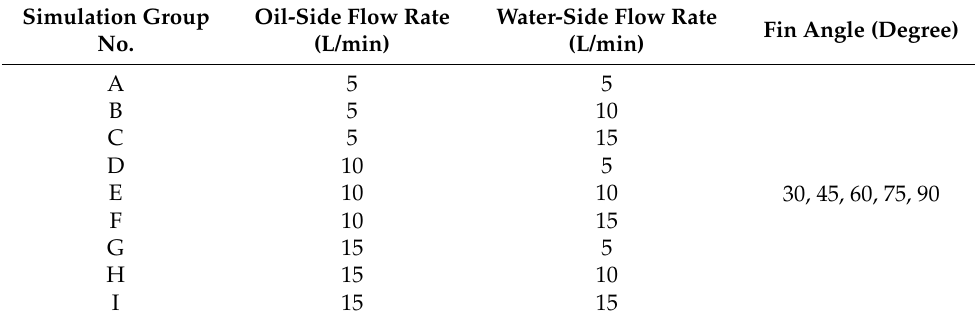
Table 4. Simulated cases of the present study.